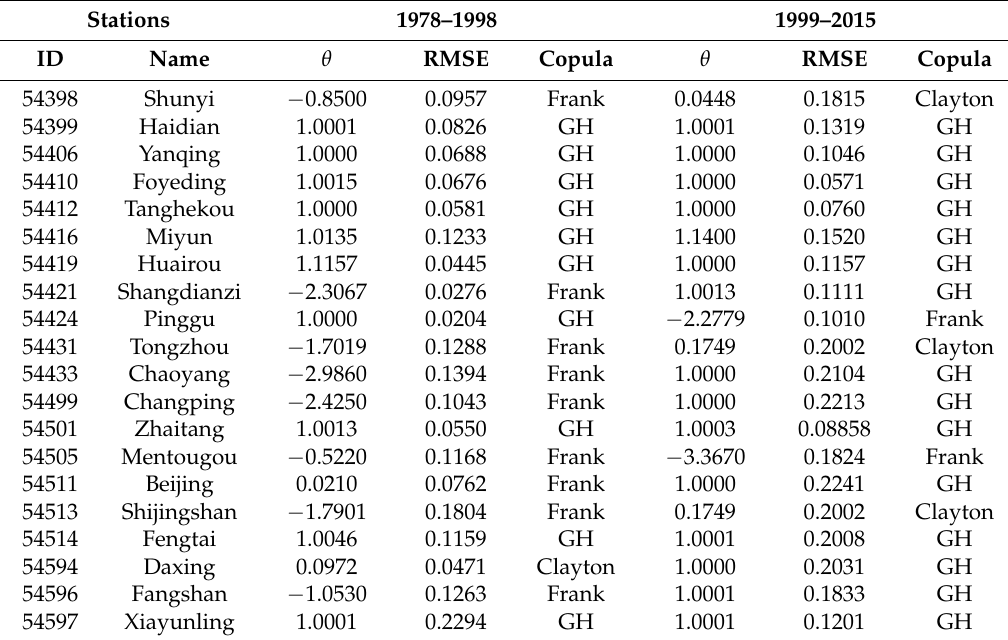
Table 8. Parameter estimation and root-mean-square error (RMSE) for selected copula distributions for 20 meteorological stations in Beijing.